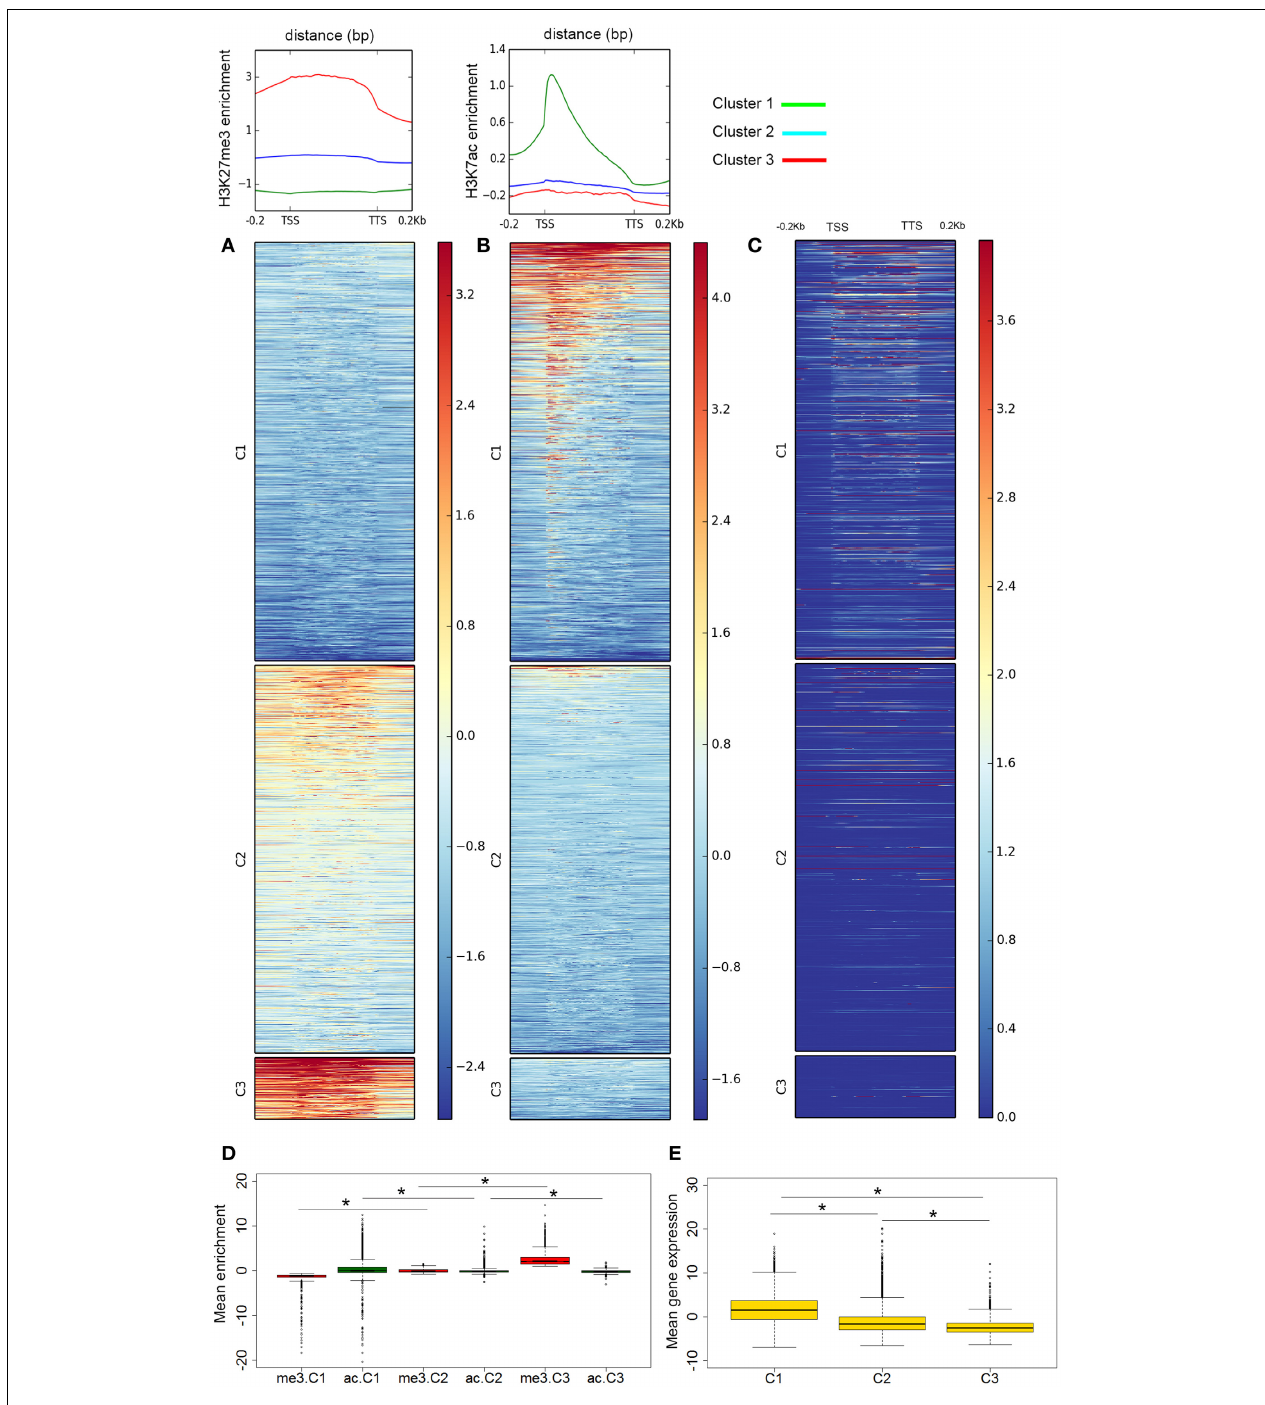
FIGURE 2 | Genome-wide distribution of histone modifications. Distribution of (A) H3K27me3 and (B) H3K27ac with respect to gene features in A. gambiae midguts. The enrichment or depletion is shown relative to chromatin input. The regions in the map comprise gene bodies flanked by a segment of 200bp at the 5 (cid:4) end of TSSs and TTSs. Average profiles across gene regions ± 200bp for each histone modification are shown on top. (C) Heatmap of RNA-seq data showing the level gene expression, as read count, profiled along the region. In